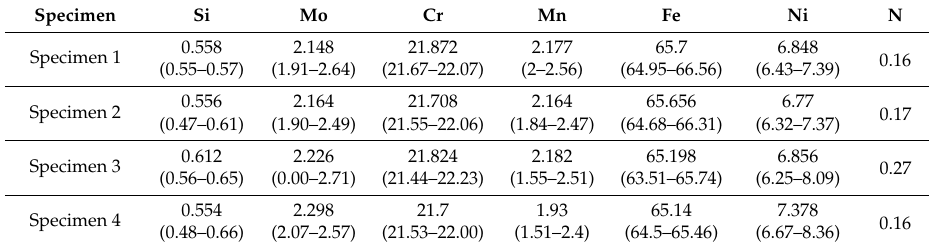
Table 4. EPMA analysis of the weld metals showing the average value (wt %). Min–max value in parentheses. Nitrogen content measured by infrared combustion method.